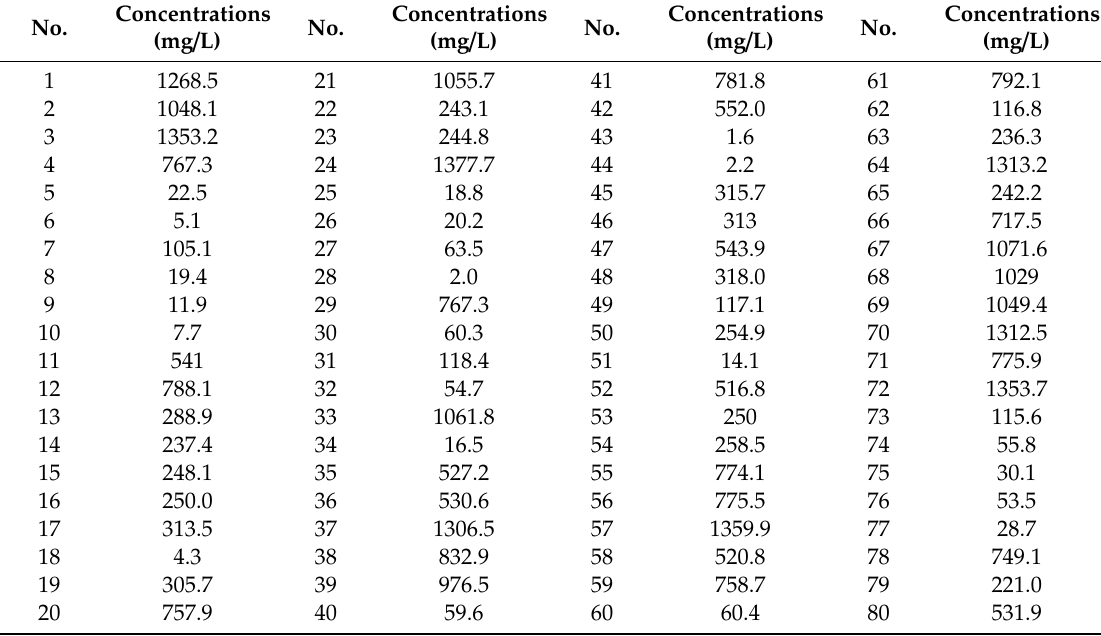
Table A1. Phosphate ion concentrations of 80 samples analyzed via ion